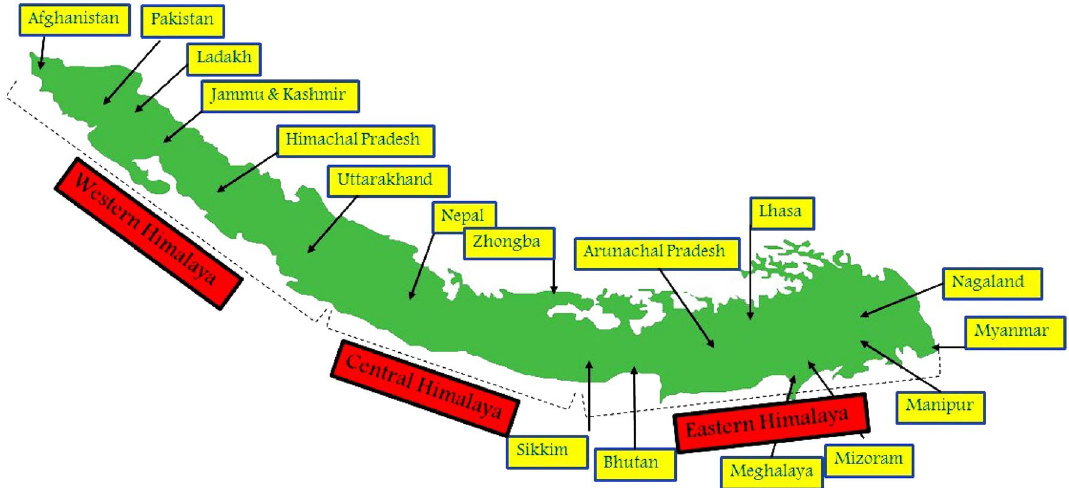
Figure 2. Map of the Himalaya showing the regions of different countries (shape file of the Himalaya extracted in Arc GIS 10.2, Environmental System Research Institute, 2011 https:// www. arcgis. com).